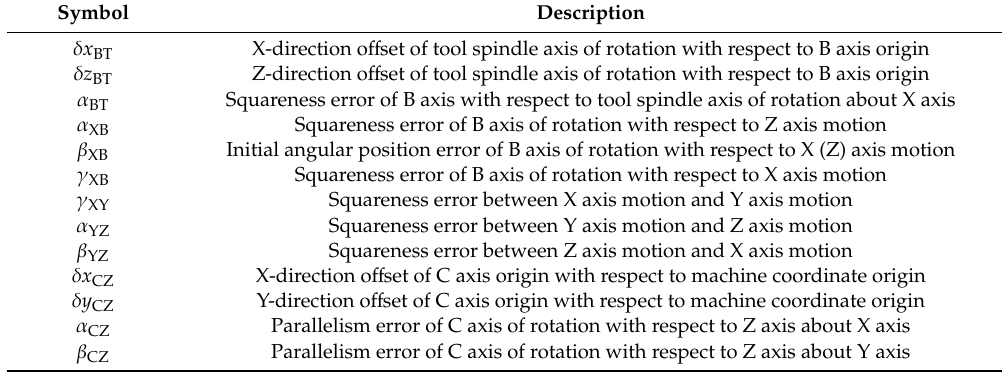
Table 1. Symbols of geometric deviations and descriptions.